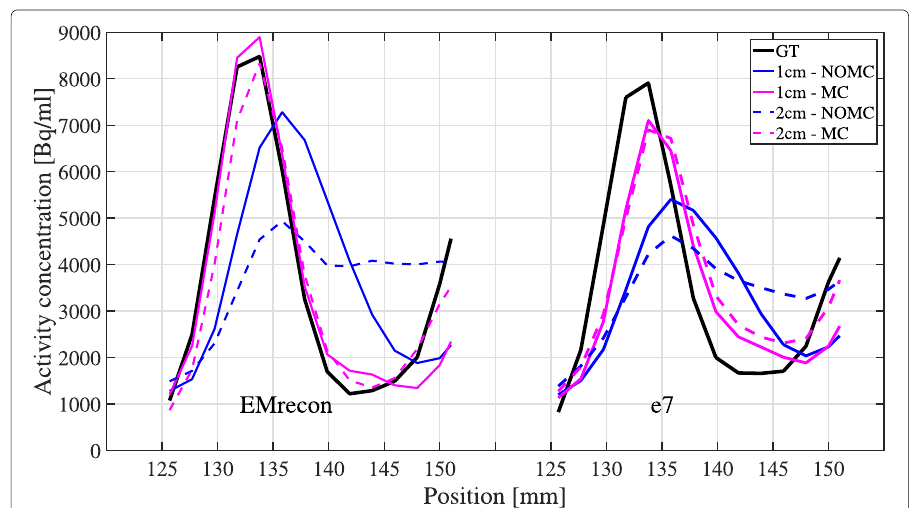
Fig. 6 Line profiles (sagittal plane, see arrow in Fig. 4) through the lesion for EMrecon (left) and e7 (right)